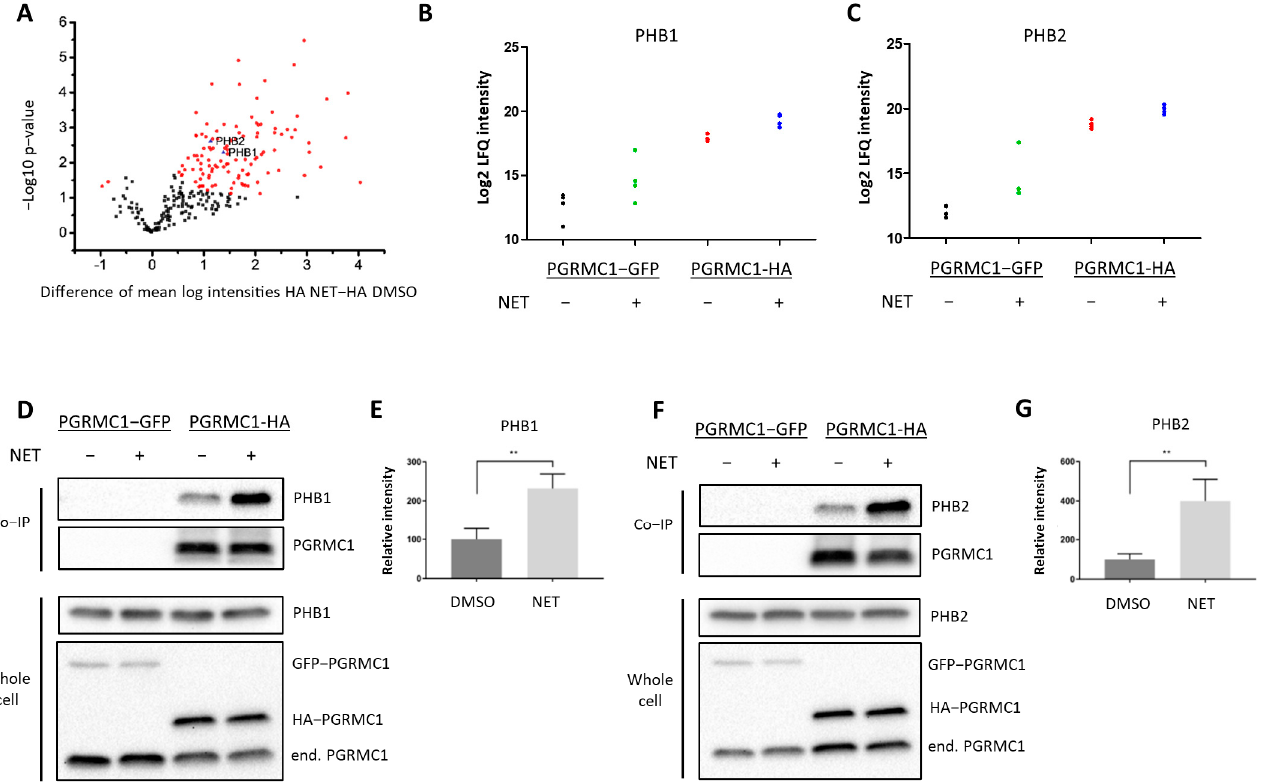
Figure 2. PGRMC1 interacts with the ER α -modulators PHB1 and PHB2 upon treatment with NET. Analysis of immunopurified (HAbased) samples of MCF7/PGRMC1-GFP cells (PGRMC1-GFP) and MCF7/PGRMC1 cells (PGRMC1-HA) treated with DMSO or NET (10 − 6 M) for co-precipitated proteins. ( A ) Volcano plot showing the result of a Welch’s t -test including 253 proteins with an increased abundance as revealed by a two-way ANOVA after HA-based enrichment. Proteins represented by red dots and blue triangles show a significantly altered abundance (FDR 0.01%). Mass spectrometry results for co-precipitated ( B ) PHB1 or ( C ) PHB2, log2 normalized intensity +: significantly different (Welch’s test). ( D , F ) Western blot analysis for co-precipitated ( D ) PHB1 or ( F ) PHB2 (upper panel) and the protein level of PHB1, PHB2 and PGRMC1 in whole cell lysates from the same cells (lower panel). ( E , G ) Densitometric analysis for precipitated ( E ) PHB1 or ( G ) PHB2. Signal intensity was normalized to PGRMC1-HA/DMSO. Difference between DMSO- and NET-treated samples was calculated with unpaired Student’s t -test. **: p <